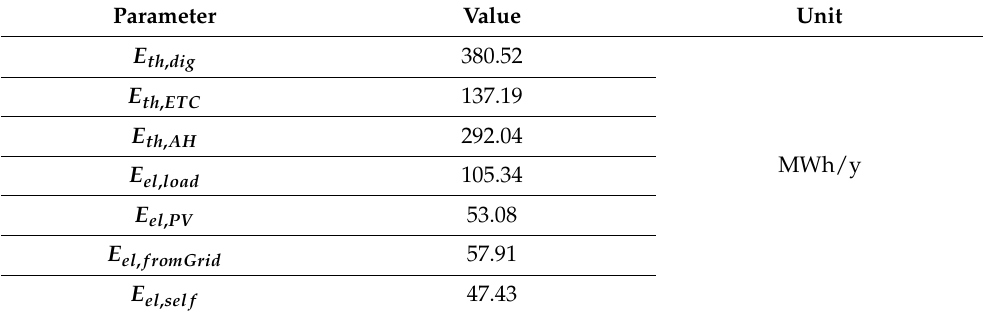
Table 4. Yearly values of energy